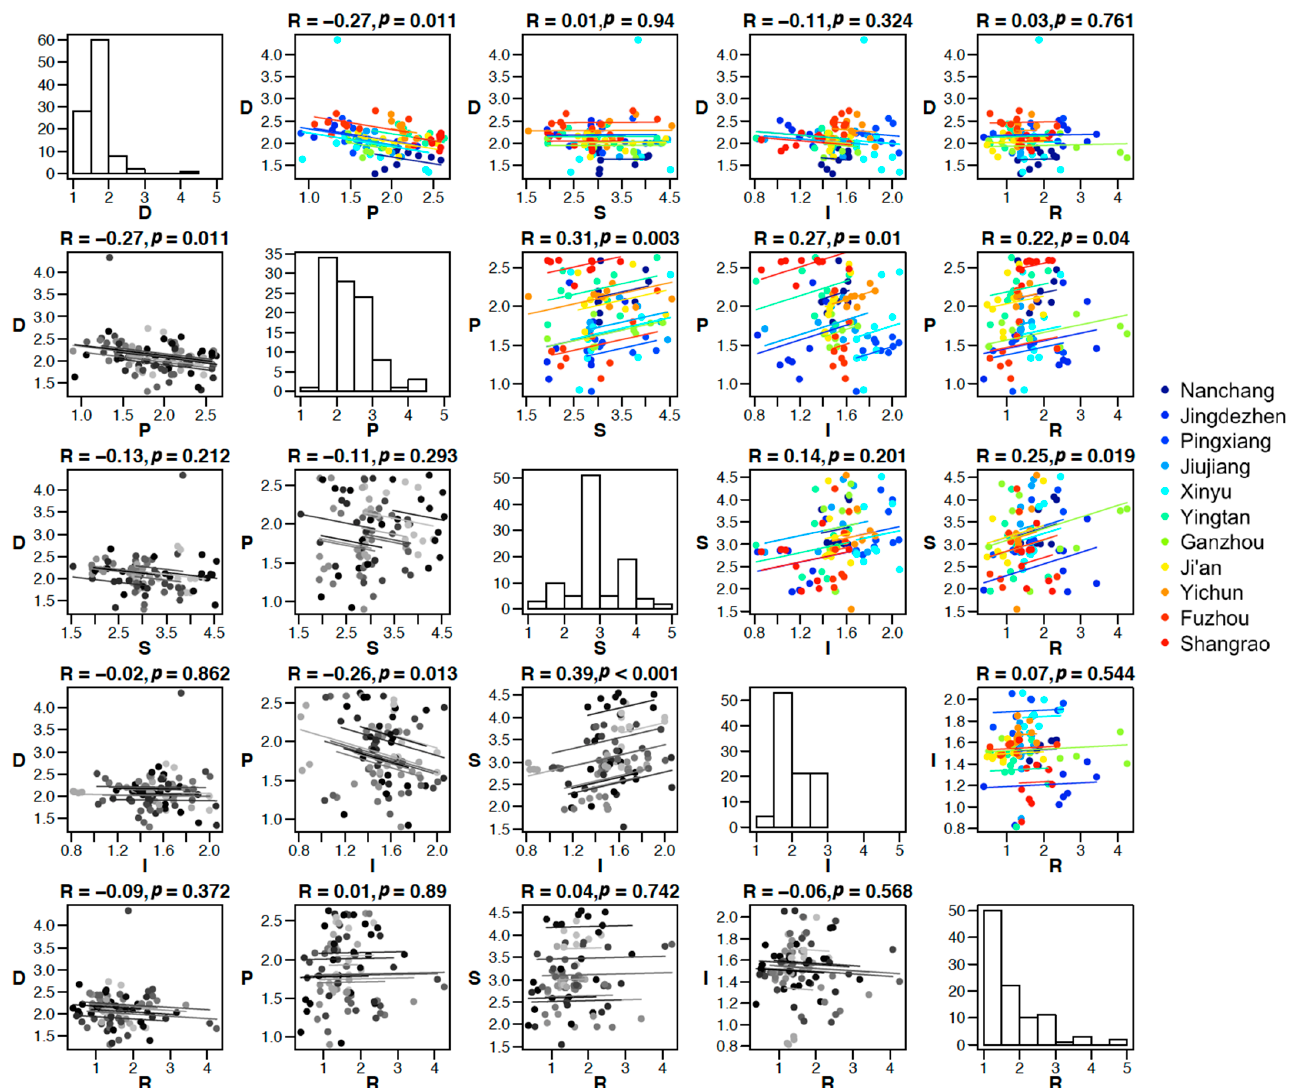
Figure 4. The repeated measures correlations among the DPSIR water security estimates of the 11 cities in Jiangxi Province during 2010–2018; data in the upper triangular are grouped by cities, and different colors indicate different cities; data in the lower triangular are grouped by years, and different intensity of the grey indicates different years .